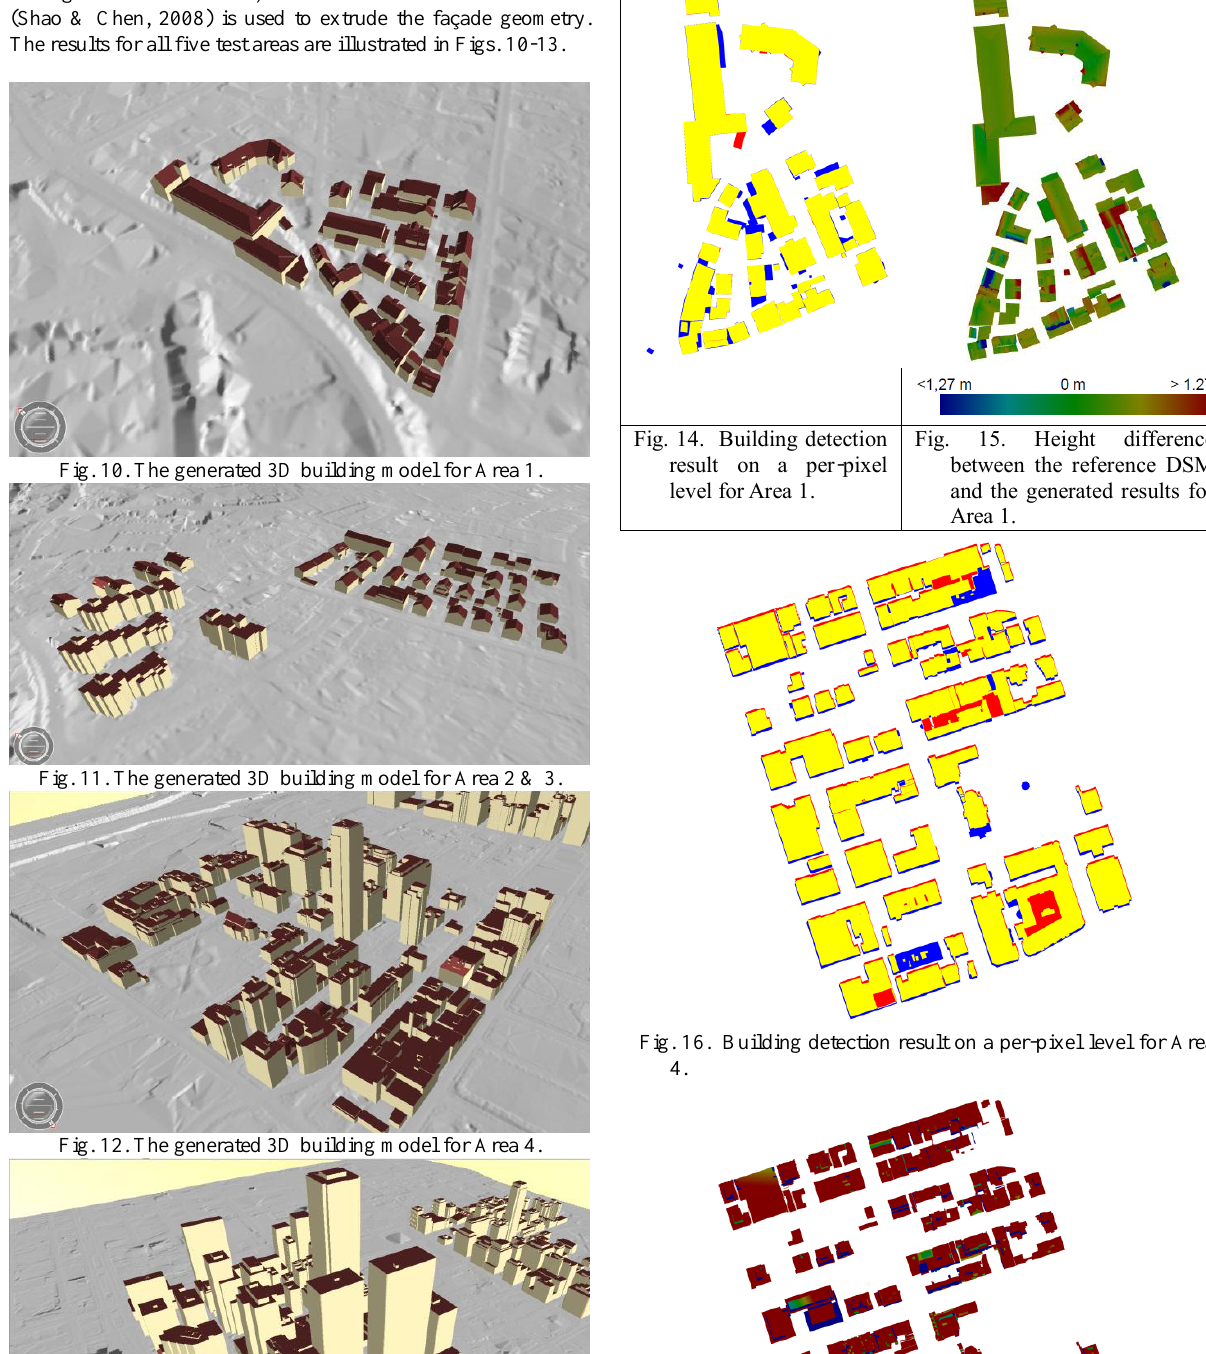
Fig. 12. The generated 3D building model for Area 4.